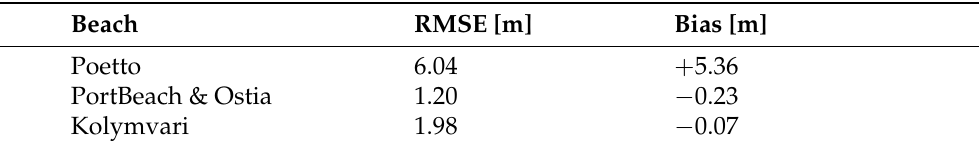
Figure 6. ( A ) Root mean square error (RMSE) and ( B ) Bias in meters between the shorelines digitised by the two users for each data and AoI considered in the study. Table 5. Time-averaged RMSE and bias in meters resulting from the user-digitized shoreline compar- ison per